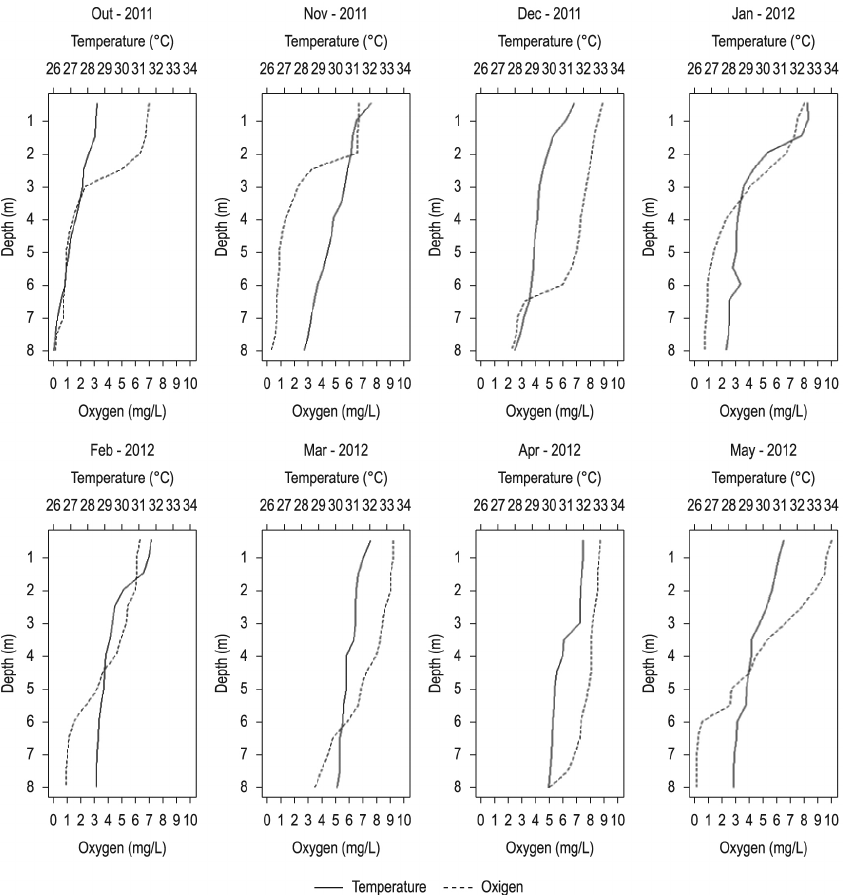
Figure 2. Vertical profile of temperature (°C) and dissolved oxygen (mg.L –1 ) in the reservoir Pau dos Ferros during the